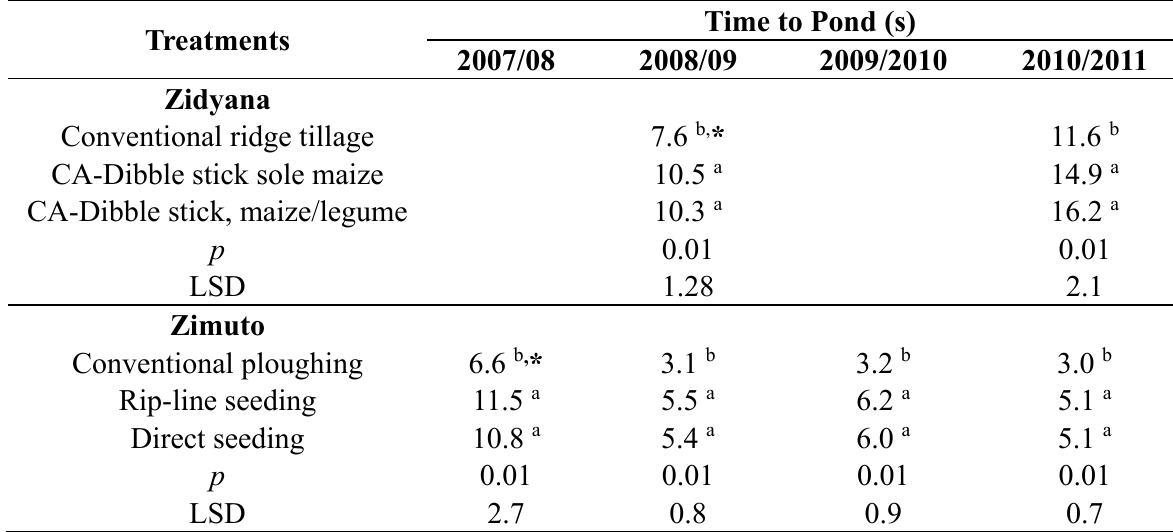
Table 3. Influence of conservation agriculture and conventional cropping systems on the time to pond (s) in Zimuto Communal Area, Masvingo, Zimbabwe 2008–2011 and Zidyana, Nkhotakota, Malawi 2008 and 2011.